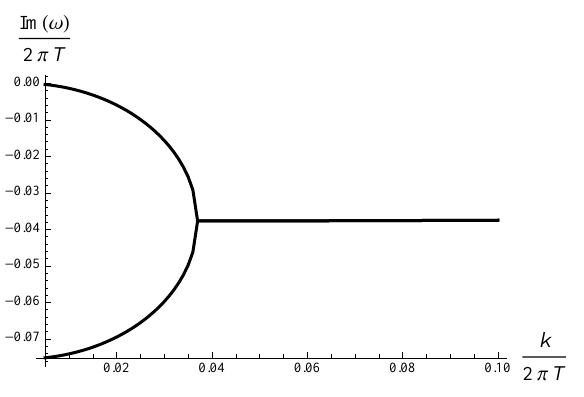
Figure 2: Movement of imaginary part of diffusion pole (top) and damped plasma oscillation pole (bottom) as a function of momentum k . We have fixed r (cid:63) π